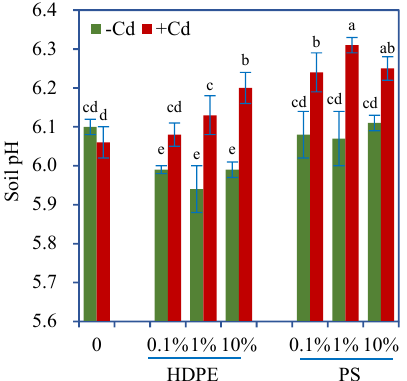
Figure 2. pH (mean ± SE, n = 4) of soil exposed to MPs with or without Cd. +Cd and ‐ Cd represent the treatments with or without 5 mg/kg Cd, respectively. Different letters over the bars indicate significant differences using a one ‐ way ANOVA followed by Duncan’s multiple range test ( p < 0.05). Two ‐ way and three ‐ way ANOVA results are shown in Tables 2 and 3, respectively.